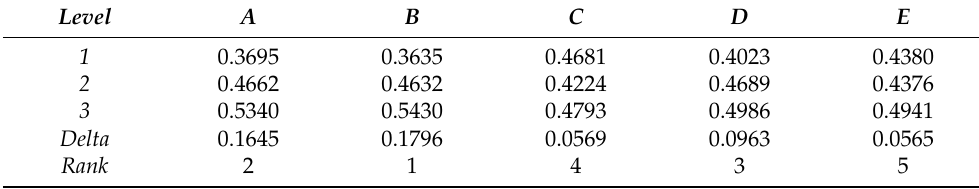
Table A2. NSGA-II response table for